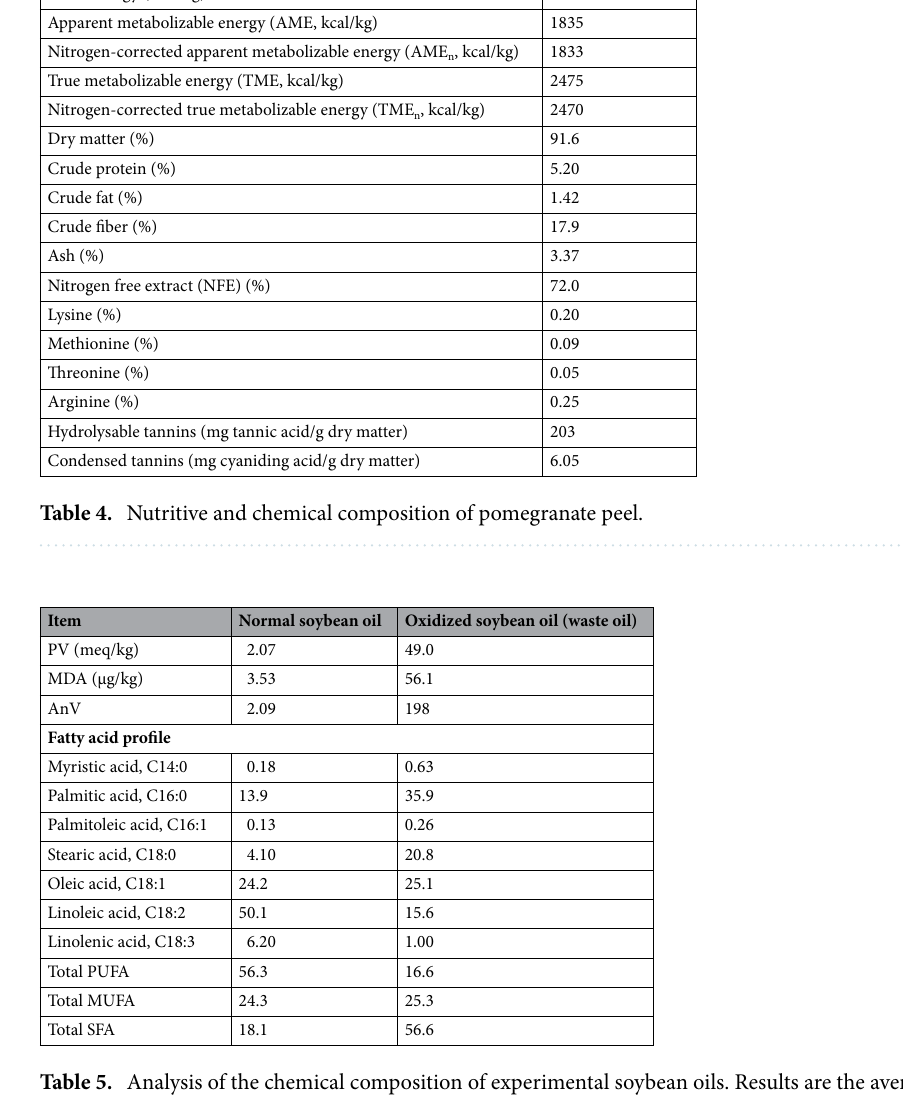
Table 5. Analysis of the chemical composition of experimental soybean oils. Results are the average of four analyses ± SD. PV peroxide value, MDA malondialdehyde, AnV anisidine value soybean oil was heated up for 18 h at 180